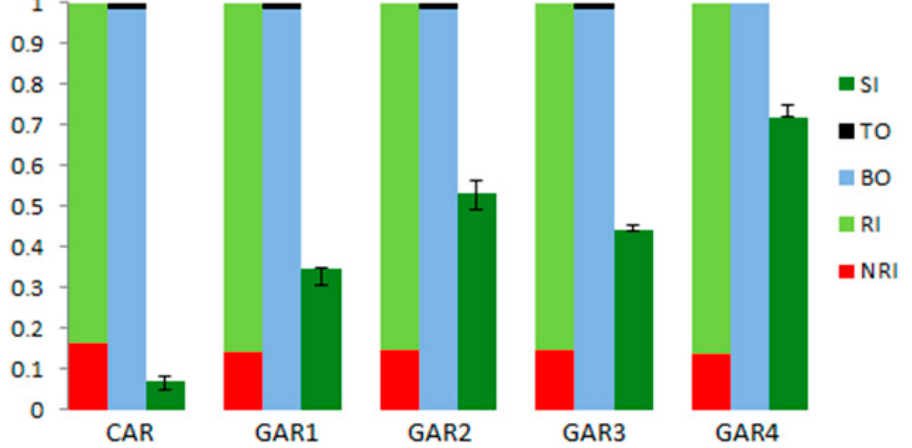
Figure 5. Graphical representation of the results obtained in terms of both materials flow and sustainability analyses. SI: sustainability index; TO: technical output rate; BO: biological output rate; RI: renewable input rate; NRI: non-renewable input rate; CAR: conventional artificial reef;. GAR1: 10% of cement replaced by shells and 25% of steel substituted by eucalyptus; GAR2: 20% of sand replaced by shells and 25% of substitution for the steel; GAR3: 5% of cement and 10% of sand replaced by shells; 25% of substitution for the steel; GAR4: 5% and 10% of substitution for cement and sand, 100% of replacement for steel.